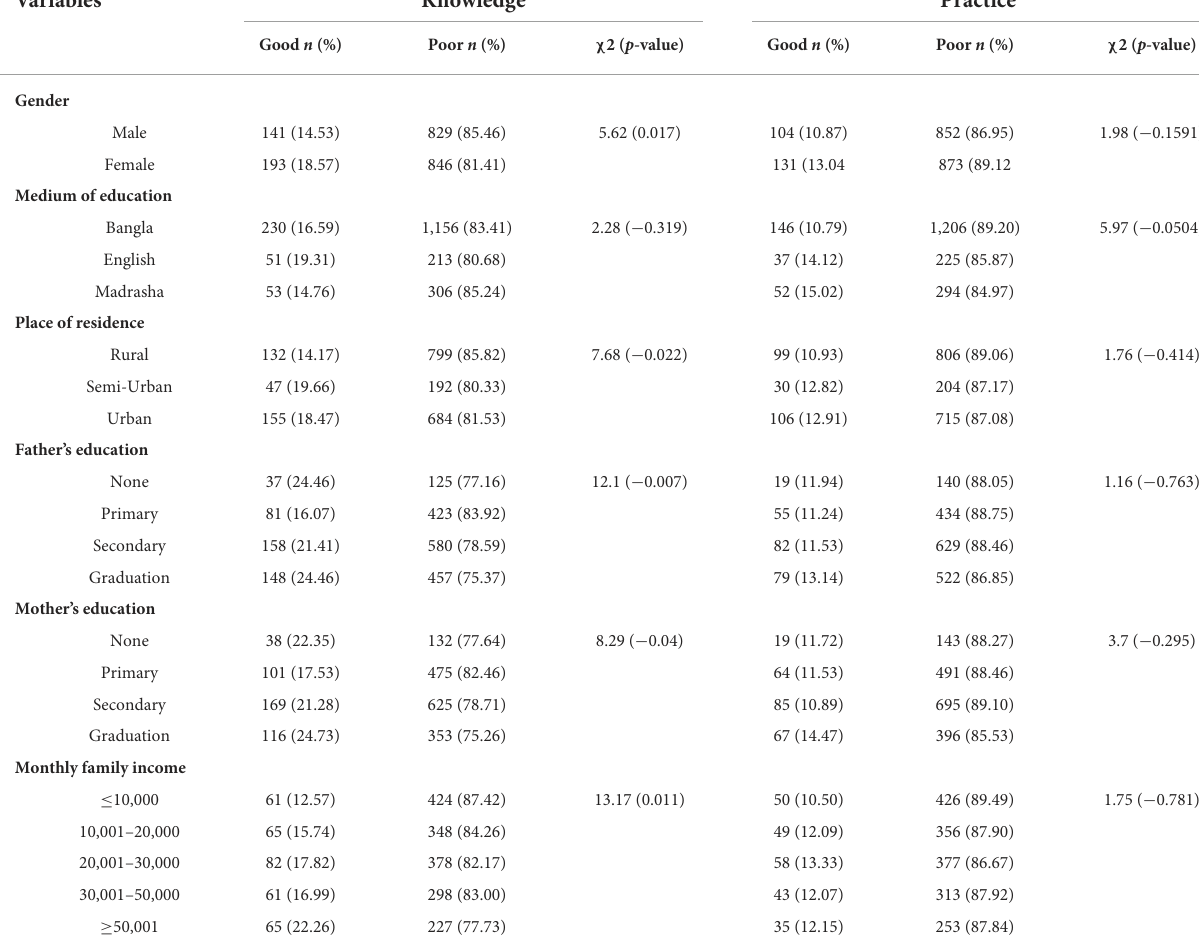
TABLE 5 Relationship among knowledge and practice with socio demographic